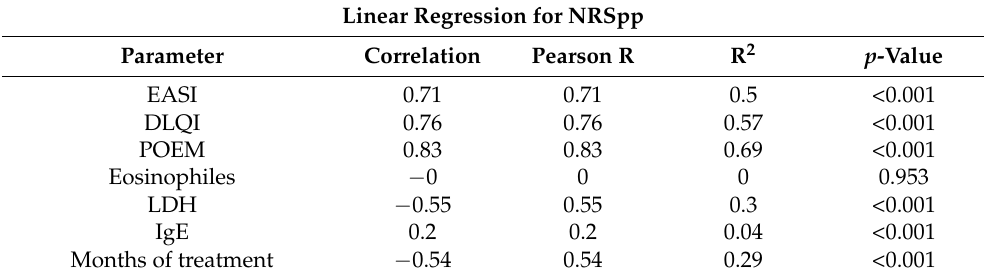
Table 3. Linear regression for NRSpp.